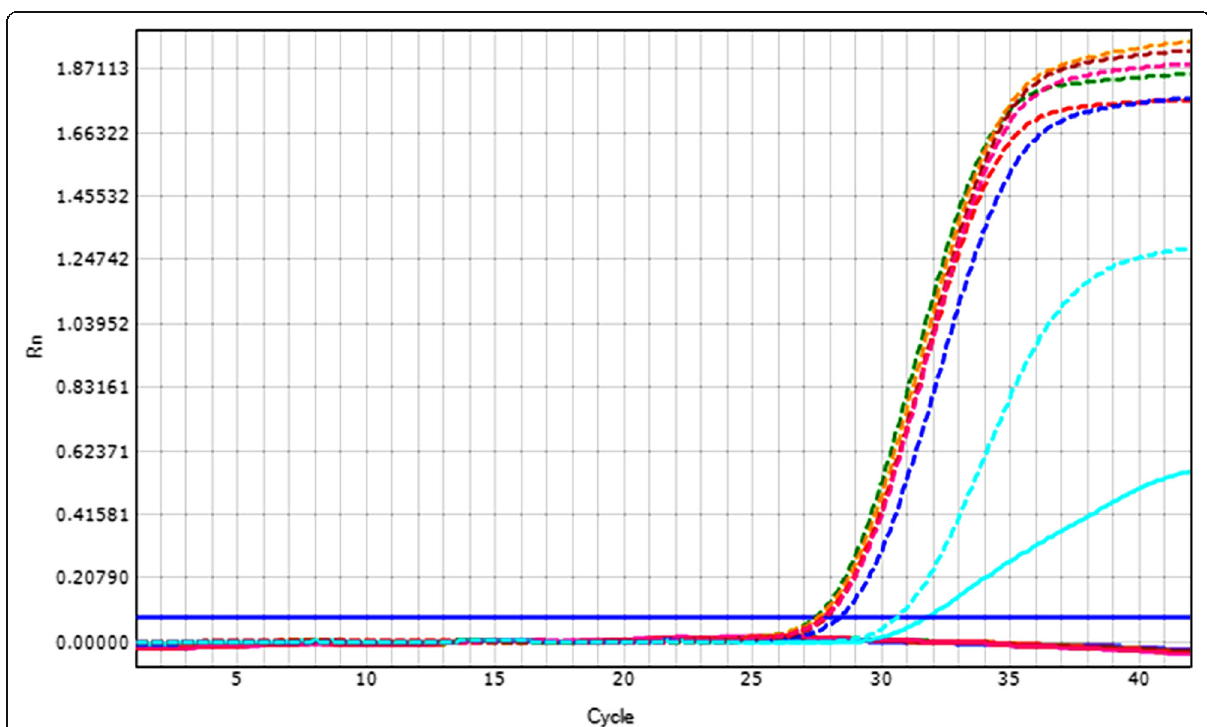
Fig. 1 AML patients examined for both IDH1rs11554137 and IDH2R140Q SNPs mutations (each in a separate well) by real-time PCR. Wild gene is detected by FAM filter (dotted line), whereas mutant gene is detected by HEX filter (straight line). Rn is the fluorescence of the reporter dye divided by the fluorescence of a passive reference dye. AML, acute myeloid